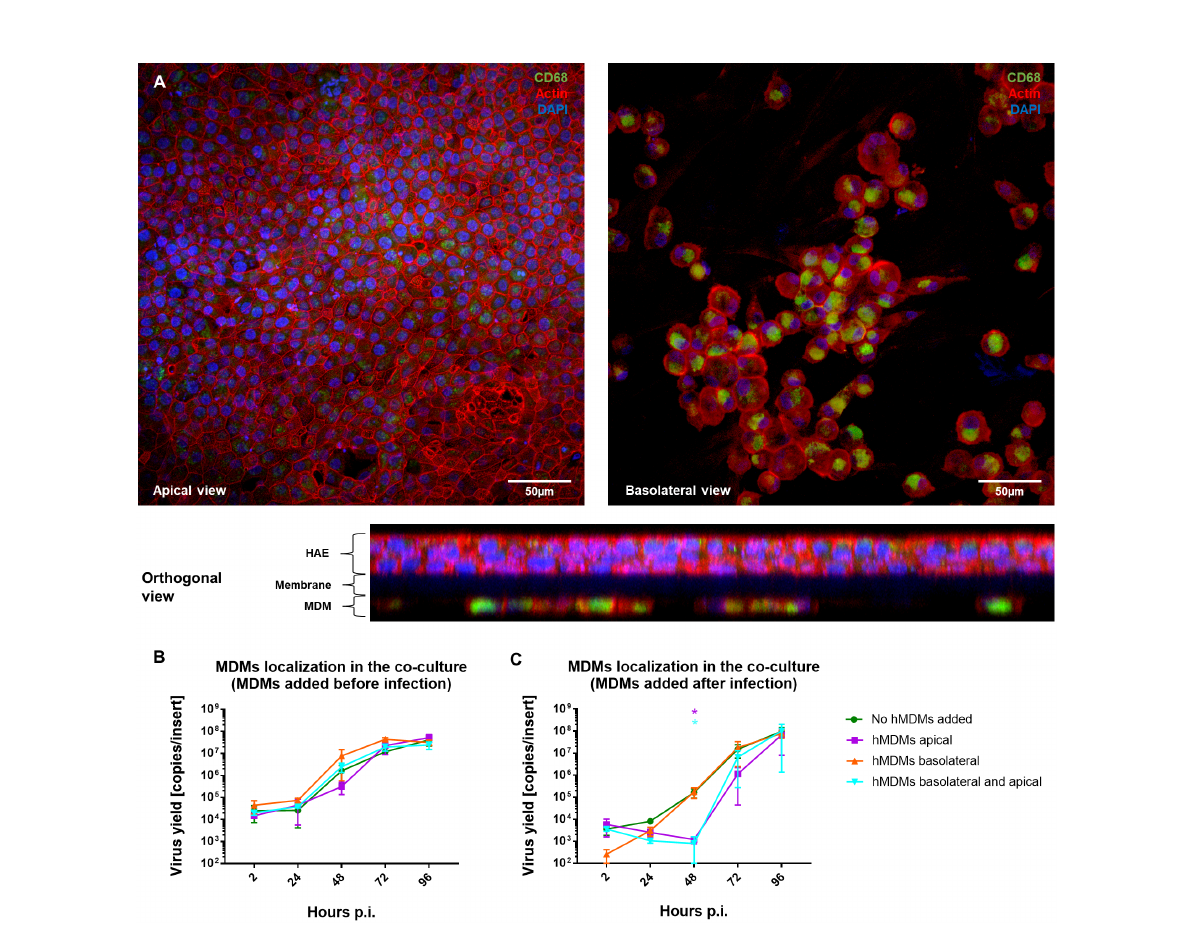
FIGURE 4 Comparison of the basolateral and apical placement of hMDMs in hMDMs-HAE co-cultures. hMDMs-HAE co-cultures where hMDMs were placed both apically and in the basolateral side. (A) Confocal images showing the apical, basolateral and orthogonal view of the co-cultures. HAE-hMDMs co-cultures were fi xed 72 hpi and stained for CD68, hMDMs marker (green), actin (red) and DAPI (blue). (B, C) Quanti fi cation of viral replication in co-cultures, evaluated by qPCR. (B) Shows virus yields expressed as RNA copies per milliliter in co-cultures where hMDMs were added before infection and (C) after infection. Data were obtained from three independent experiments, each experiment was carried out in triplicate and means ± SEM is shown. Groups were compared by the Kruskal-Wallis test and Dunn ’ s multiple comparisons test. *p <